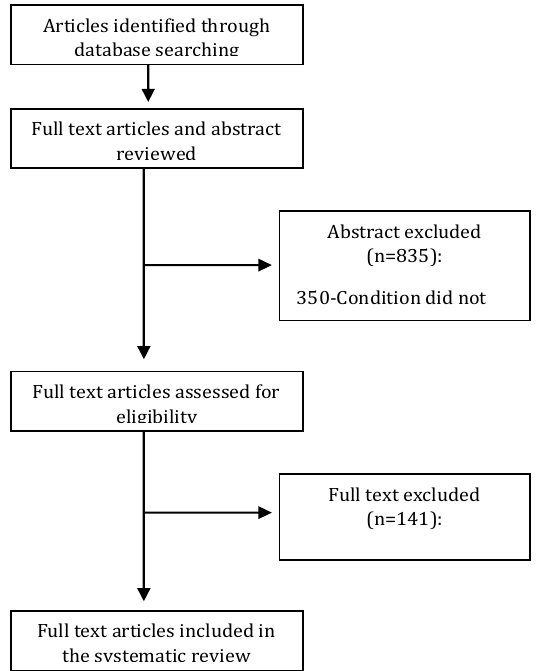
Figure 1. Flow diagram of the search and selection article